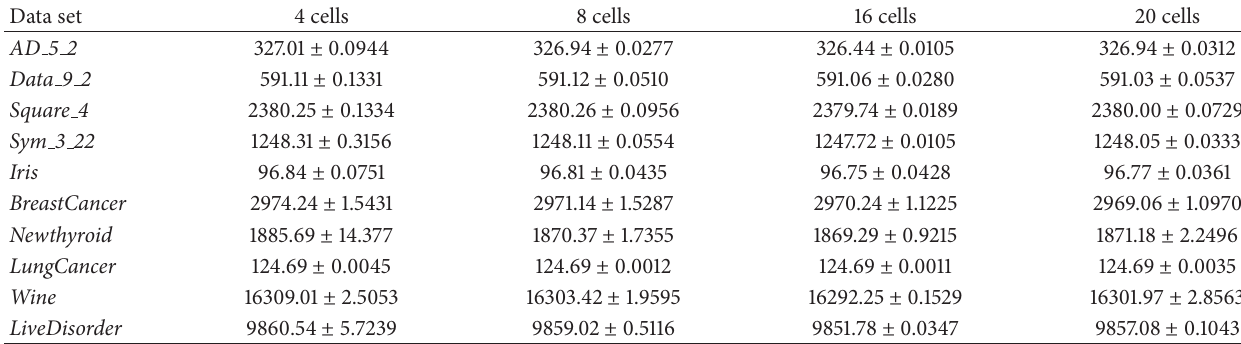
Table 2: The performance comparisons of tissue-like P systems of different